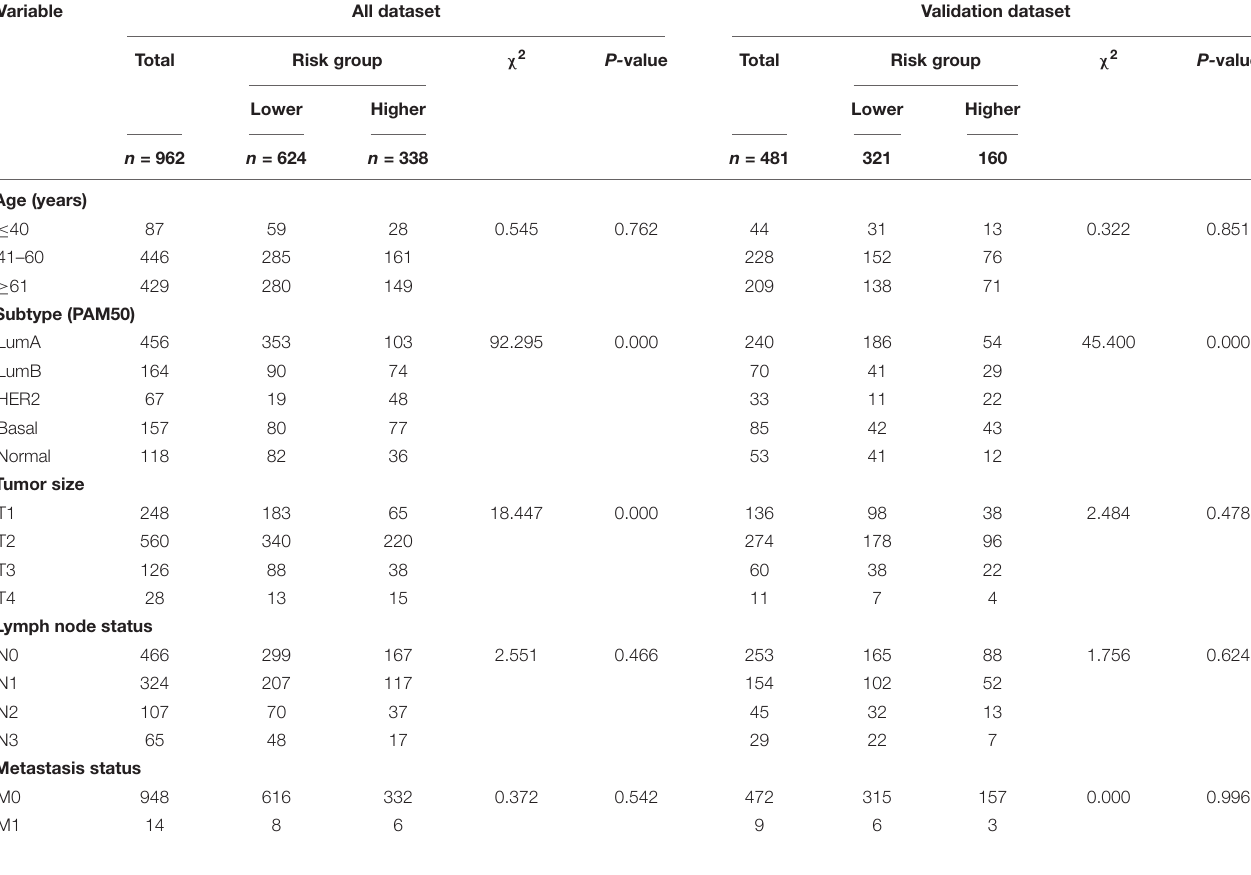
TABLE 4 | Demographic, clinical, and pathologic characteristics of the patient with breast cancer.